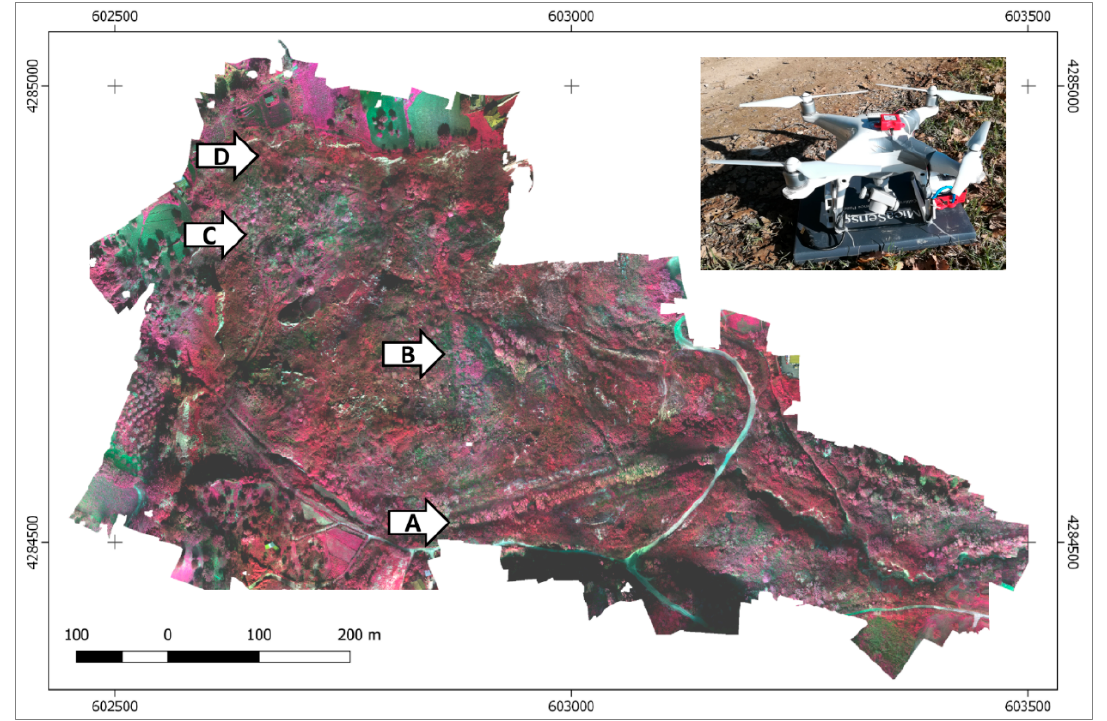
Figure 8. CIR orthoimage resulted from the multispectral (MS) flight; in the inset picture: UAV equipped with MS sensor. Arrows indicates peculiar sectors of the orthoimage where vegetation dynamics are interpreted.